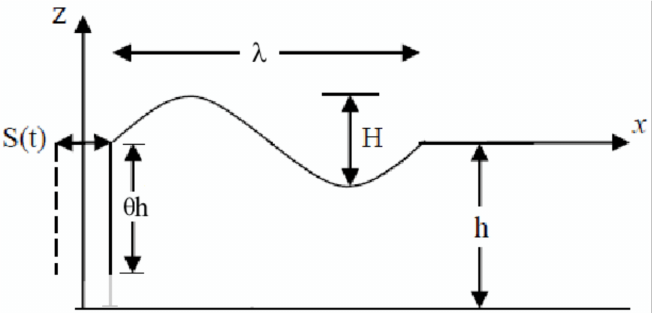
Figure 1. Schematic diagram of the piston wavemaker reduced to a limited depth θ h . H is the wave height, λ is the wavelength, h is the water depth, S is the wavemaker stroke, and 0 < θ ≤ 1.0 is a